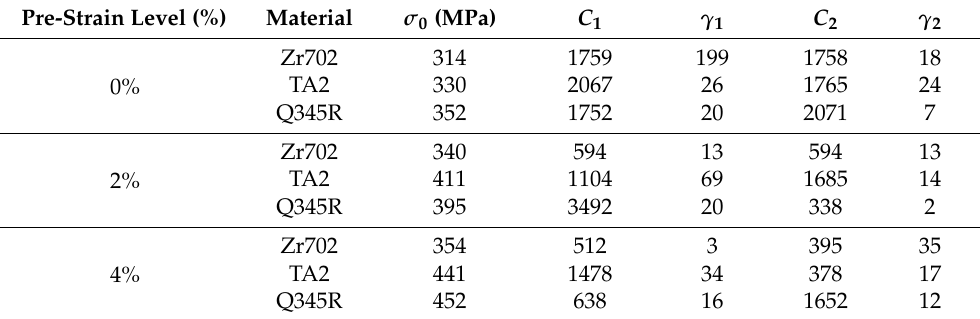
Table 3. Chaboche model parameters of component materials with different pre-strain levels.